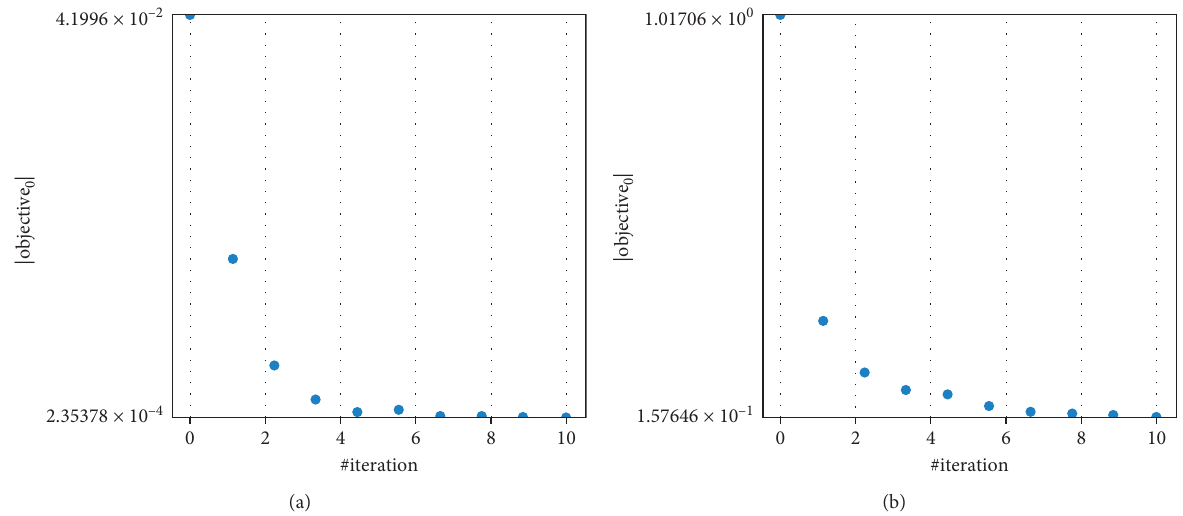
Figure 8: The effect of fine-tuning on the convergence rate of the method. Solving Example 2 with (a) fine-tuning and (b) without fine-tuning.